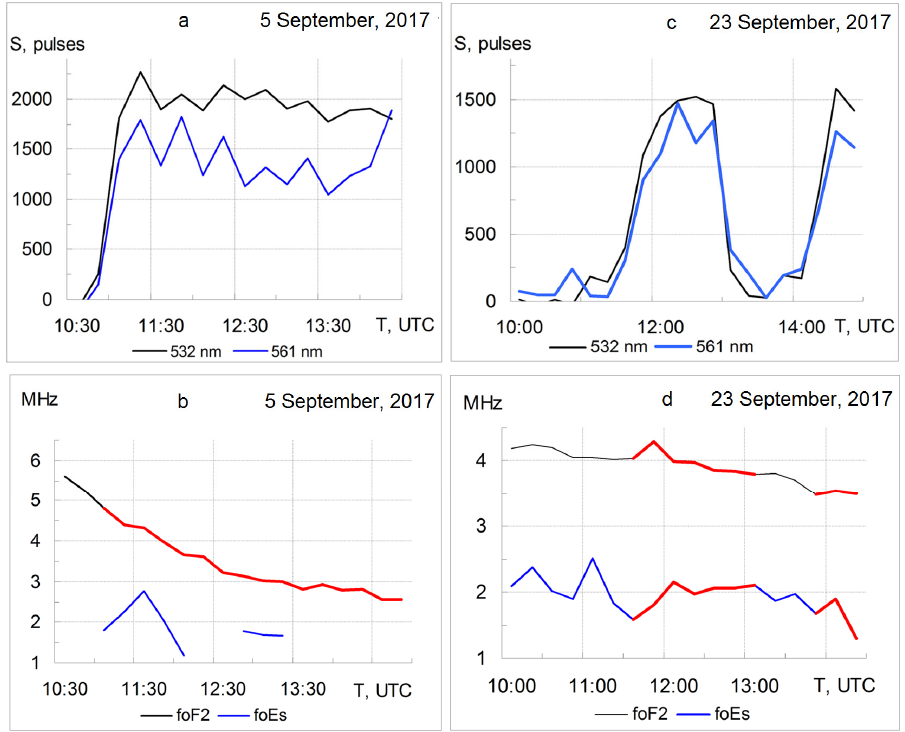
Figure 7. Lidar signal with background substracted summed over a 200–400 km layer ( a , c ) and the critical foF2 and foEs frequencies ( b , d ) during lidar observations on 5 and 23 September